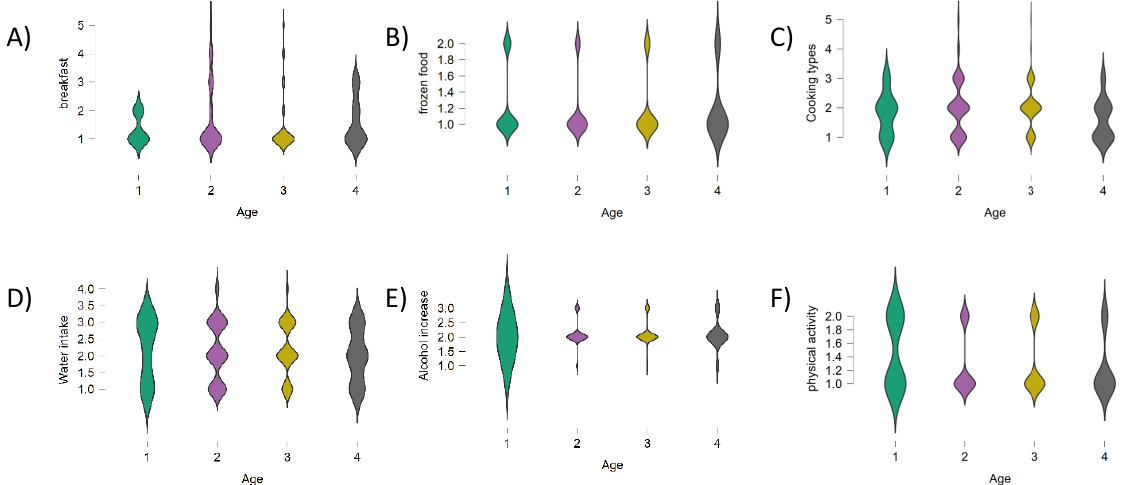
Figure 2. Violin plots created with JASP (www.jasp-stats.org, accessed on 20 January 2021), distinguishing between four different age groups (1 = 0–17; 2 = 18–30; 3 = 31–55; 4 = >55) within ( A ) breakfast consumption (1 = daily; 2 = often; 3 = sometimes; 4 = rarely; 5 = never); ( B ) frozen food intake (1 = yes; 2 = no); ( C ) cooking types (1 = steam; 2 = oven; 3 = griddle; 4 = frying; 5 = microwave); ( D ) water intake (1 = yes; 2 = no); ( E ) alcohol increase consumption in respect to pre-Covid-19 period (1 = yes; 2 = no; 3 = no variation); ( F ) physical activity practice (1 = yes; 2 = no).